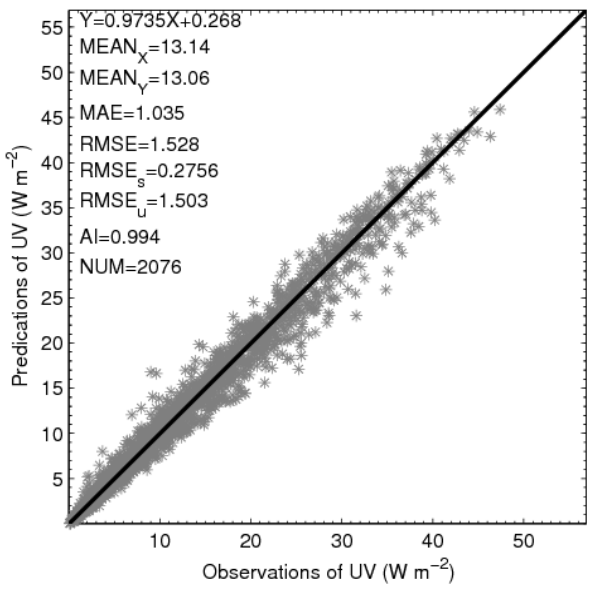
Fig. 9. Comparison between observed and estimated UV radiation under all-weather conditions. The black line represents the 1:1 re- Figure 9. Comparison between observed and estimated UV radiation under lationship. Also marked is an array of complementary differences and univariate indices. The results were obtained using the 25% of all-weather conditions. The black line represents the 1:1 relationship. Also marked is data reserved for an array of complementary difference and univariate indices. The results were obtained using the 25% of data reserved for validation.